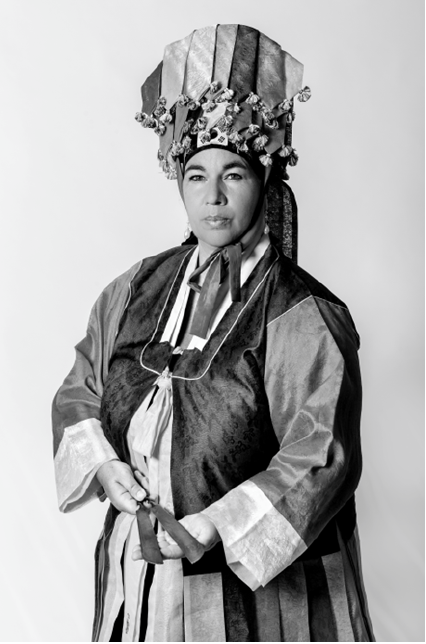
Figure 7. Andrea Kalff clad in the outfit of a mythical General, Changgun. 2021, the photograph is published with authorization from Andrea